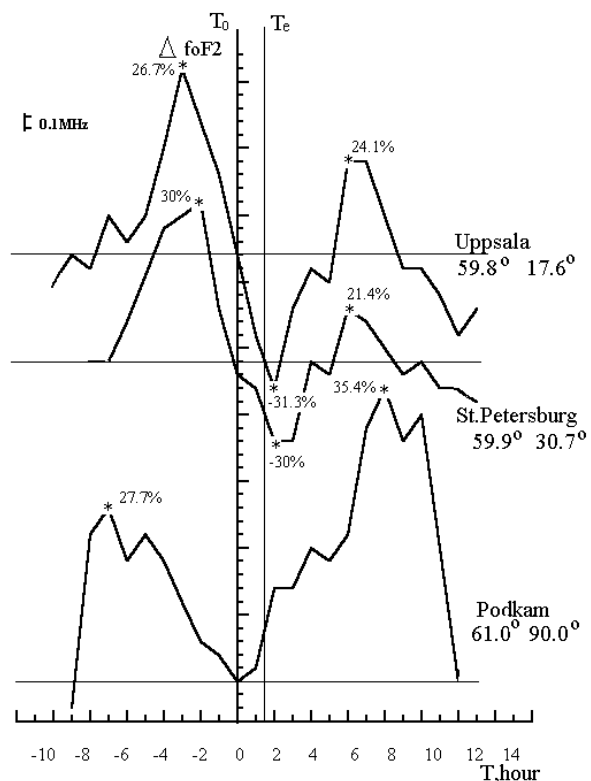
Fig. 8. The variations of 1 fo F2 values for the negative substorm that occurred on 27 March 1999 ( T o = 22:00UT, I = − 110nT, τ = 1 . 5h) through the latitudinal chain of stations of the IDCE, Upp.: LT = UT + 2, St. P.: LT = UT + 3, Pod.: LT = UT + 8. The vertical lines mark substorm onset, T o , and the end of the substorm, T e . Asterisks are δ fo F2 (%) values.